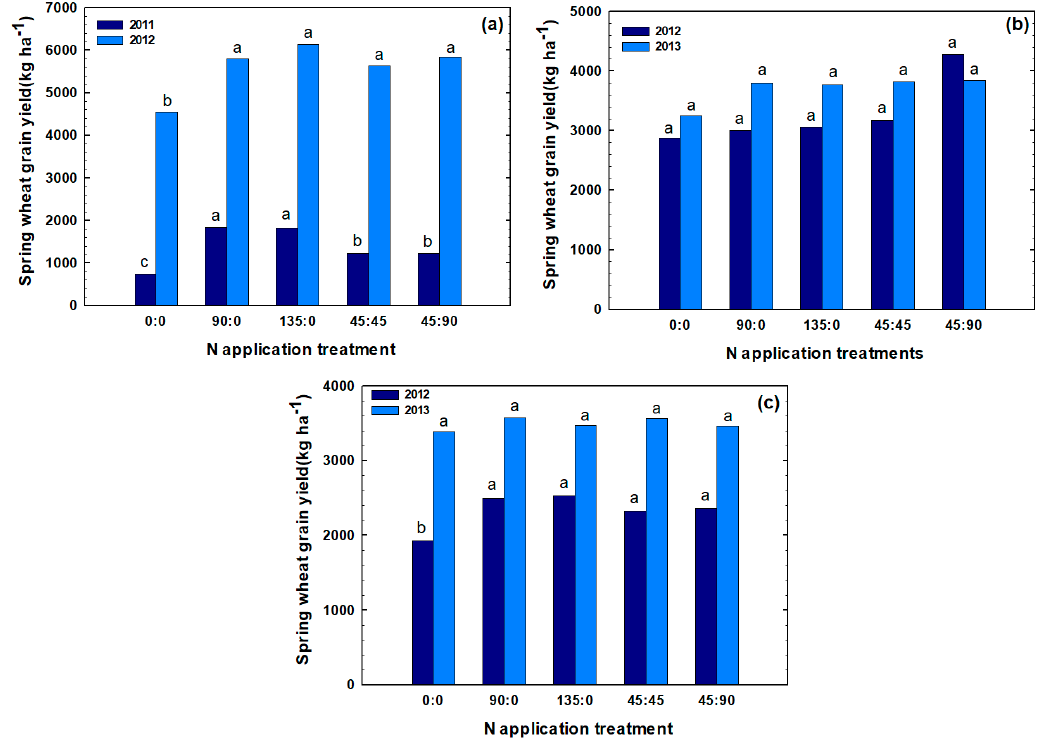
Figure 1. Effect of different nitrogen (N) rates and application time on spring wheat grain yield in Pondera ( a ), Chouteau ( b ), and Teton ( c ) in two years. Treatments were designated in the format x:y, where x and y are the fertilizer N rates in kg N ha − 1 applied at planting and at flowering, respectively. Bars within the same year followed by the same letter are not significantly different ( p > 0.05) based on a Duncan’s multiple range test.